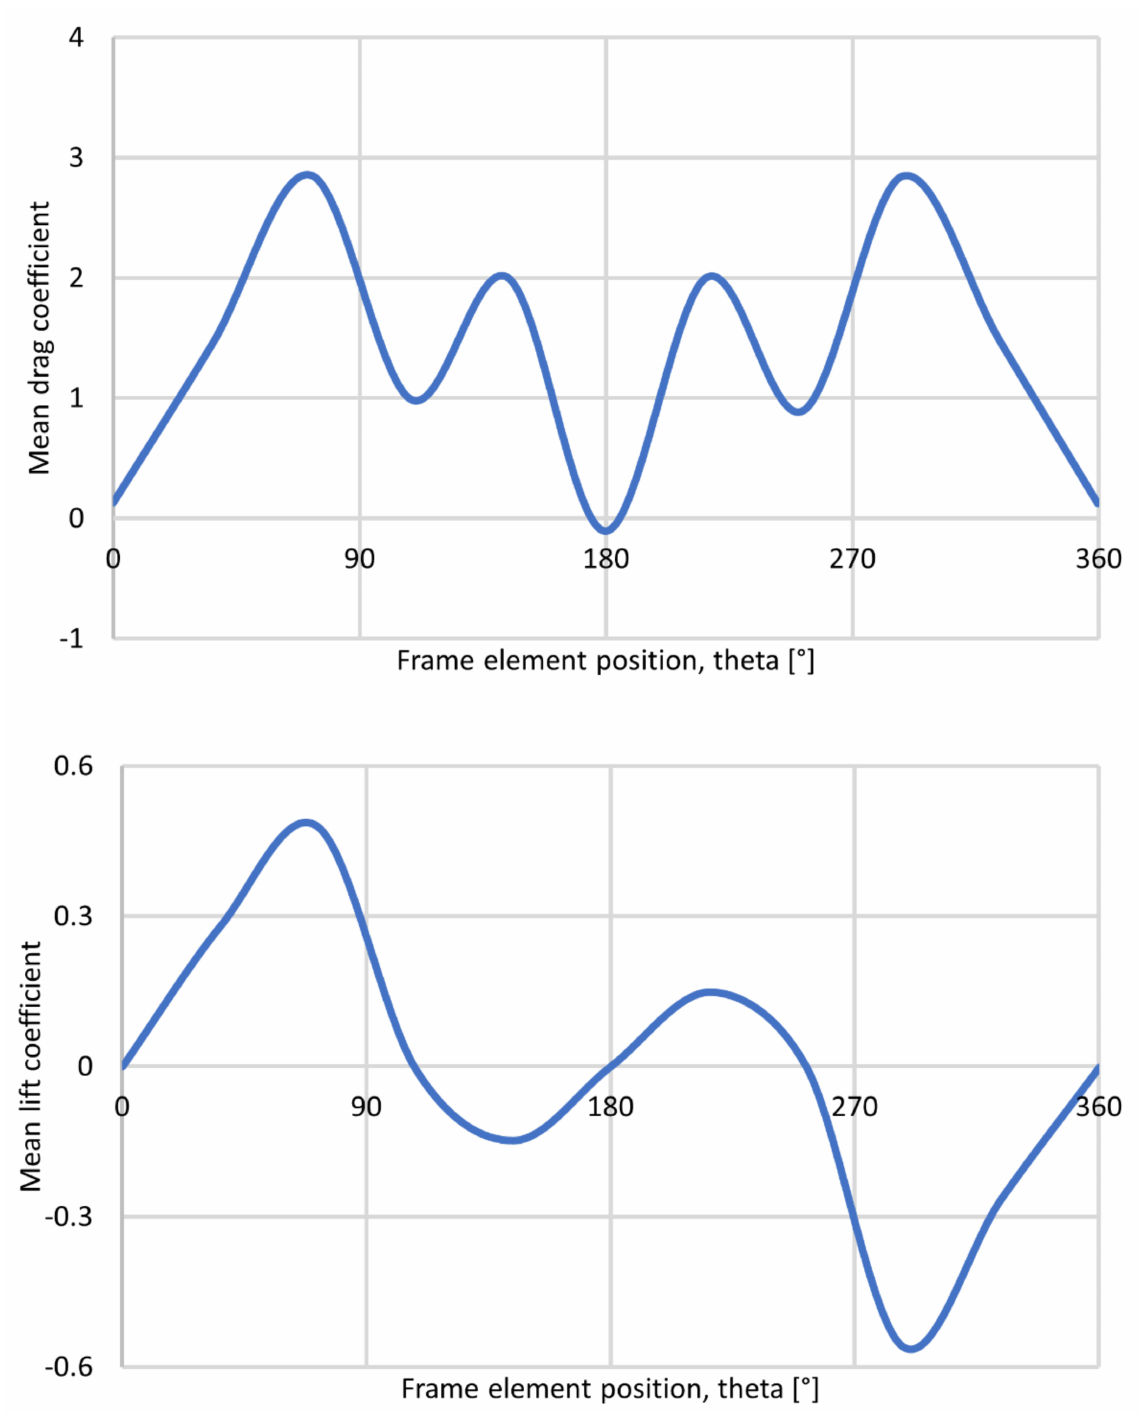
Figure 15. Mean drag ( top ) and lift ( bottom ) coefficient on the vertical helideck frame elements as a function of their angular position around the lantern chamber, for an incident wind speed of 27.1 m/s. It is shown in Figures 15 and 17 that the elements experiencing the greatest mean drag also experience the greatest amplitude of oscillation in both drag and lift. Furthermore, for elements experiencing the greatest amplitude of oscillation, the frequency of the oscillation is consistent with the expected frequency of vortex shedding for the isolated frame element in 27.1 m/s flow speed equal to 54.2 Hz [24], higher mean thrust coefficients lead to higher frequency oscillations and vice